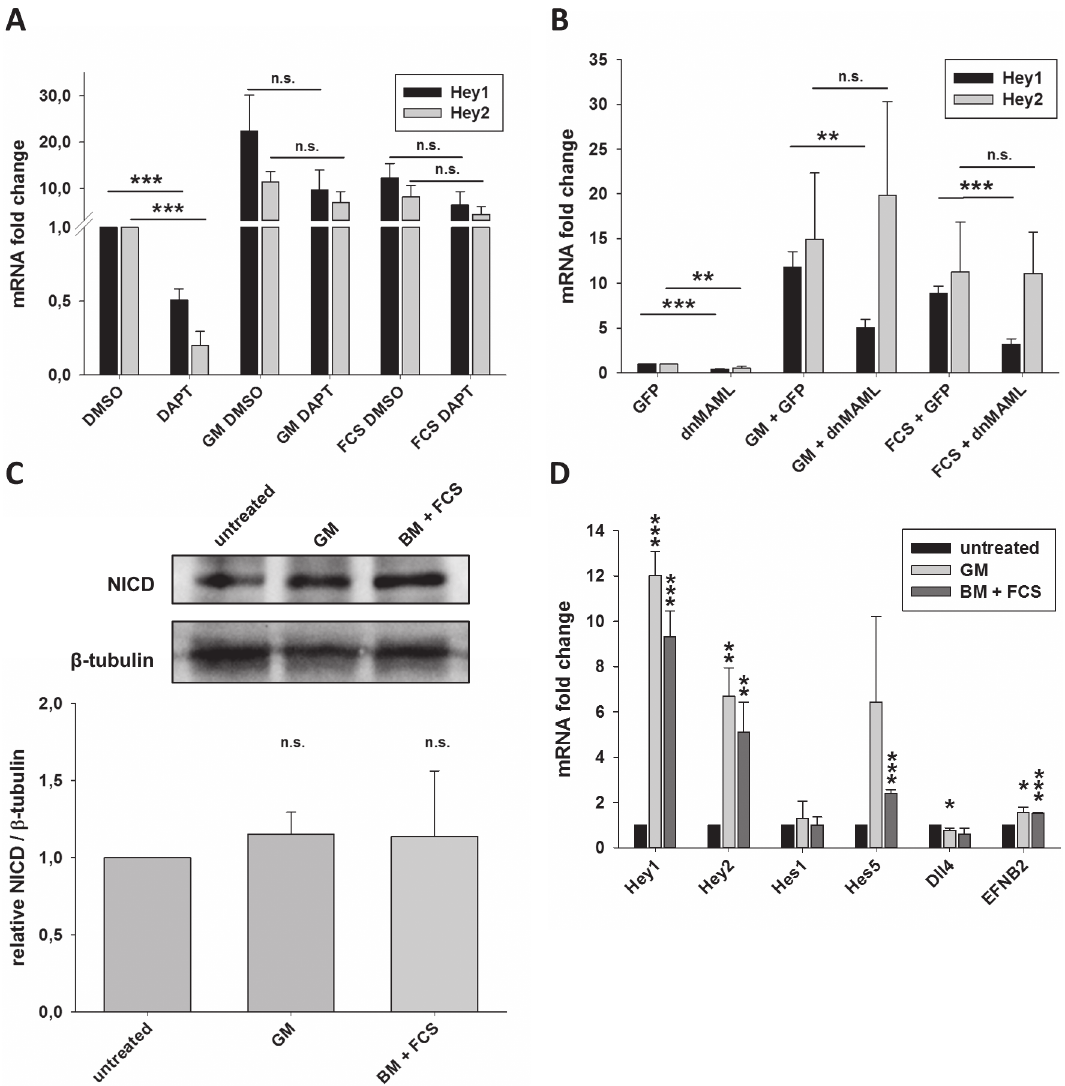
Fig 2. Induction of Hey genes by serum does not depend on Notch signaling. A) HUVEC were grown in growth medium containing 25 μ M DAPT or an equivalent volume of DMSO. Medium was unchanged (DMSO, DAPT) or changed to fresh growth medium (GM) or basal medium (BM) with 3% FCS containing DAPT or DMSO respectively. Transcript levels of Hey1 and Hey2 were measured 1.5h after medium change and are shown in relation to the sample incubated with DMSO, whose medium was not changed. B) HUVEC were transduced with adenoviral vectors expressing GFP or dnMAML. Cells were grown in growth medium. The medium was either unchanged (GFP, dnMAML) or replaced with fresh growth medium or basal medium containing 3% FCS. Transcript levels were determined after 1.5h and are normalized to the cells transduced with GFP and unchanged medium. C) HUAEC were grown in growth medium (untreated) or the medium was substituted with fresh growth medium or basal medium containing 3% FCS. The western blot is showing the cleaved intracellular domain of Notch1 (NICD) and β -tubulin 30 minutes after medium change. The chart summarizes four independent experiments and depicts the relative levels of NICD normalized for β -tubulin. D) HUVEC were left untreated or the medium was changed to fresh growth medium or basal medium supplemented with 3% FCS. After incubating 1.5h, the cells were harvested and the mRNA levels of several established Notch target genes ( Hey1 , Hey2 , Hes1 , Hes5 , Dll4 EFNB2 ) were determined. Fold changes and significances were calculated to the untreated control. Mean and standard deviation, n = 3, * p < 0.05, ** p < 0.01, *** p < 0.001, n.s. not